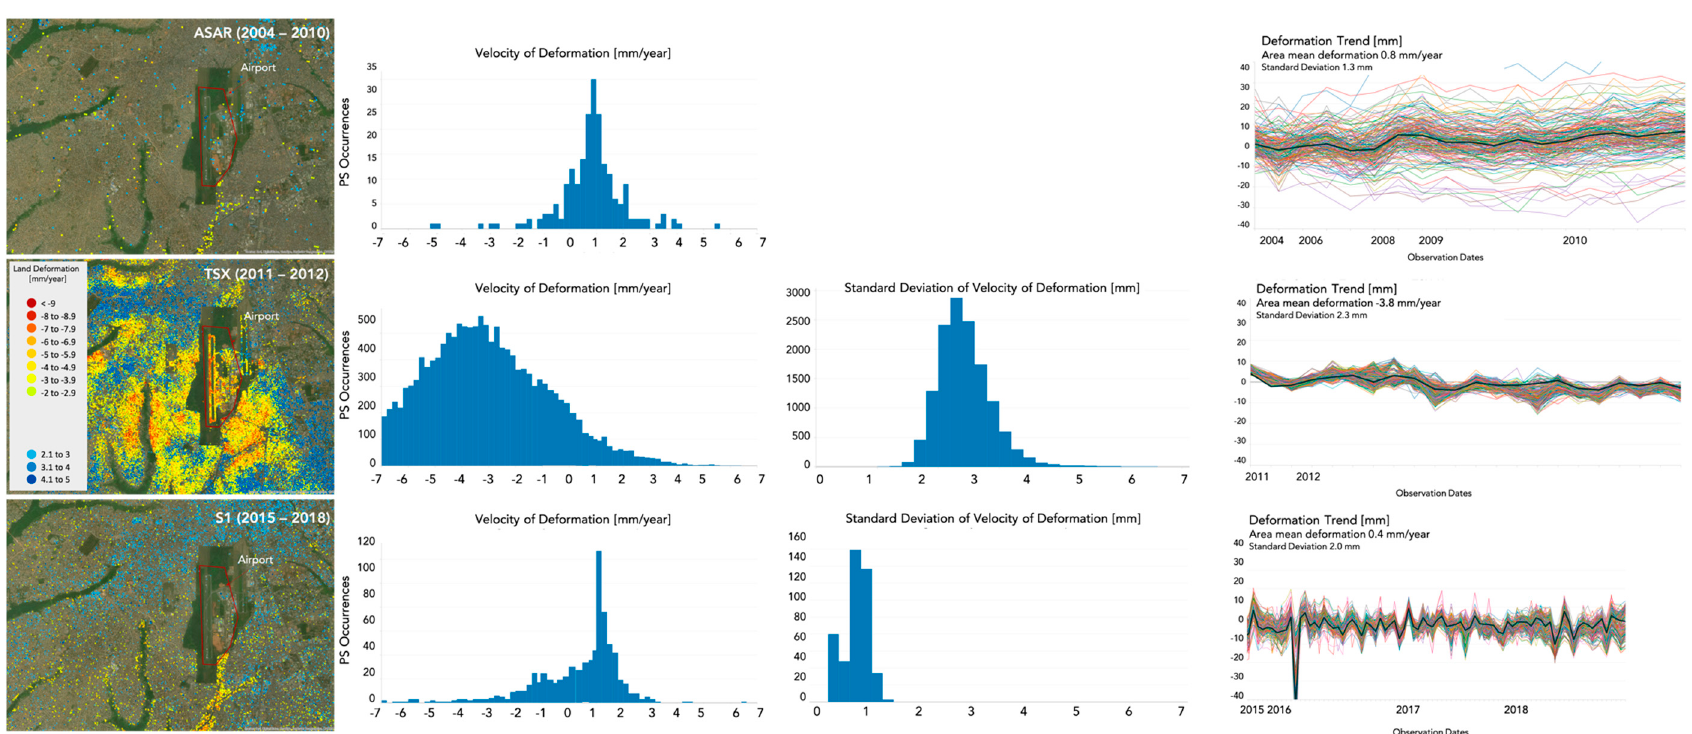
F igure 9 Lagos AOI 4. Figure 9. Lagos AOI